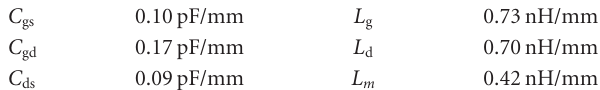
Table 1: Line parameters of test